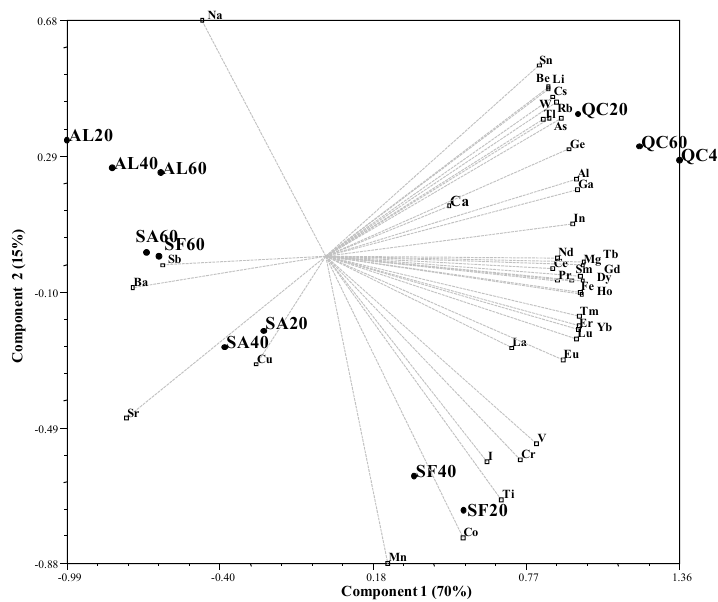
Figure 3. Principal Component Analysis performed on soils from the vineyards/DO: (AL) Vinha de Algeruz/Palmela, (SF) Quinta de S. Francisco/Óbidos, (SA) Quinta do Sanguinhal/Óbidos, and (QC) Quinta dos Carvalhais/Dão, collected at nine sampling sites and three depth levels (0–20 cm, 40–60 cm, and 60–80 cm), in a total of 27 samples, analysed in duplicate The soils are represented in the plane of the two first components which express, respectively, 70% and 15% of the total variance.